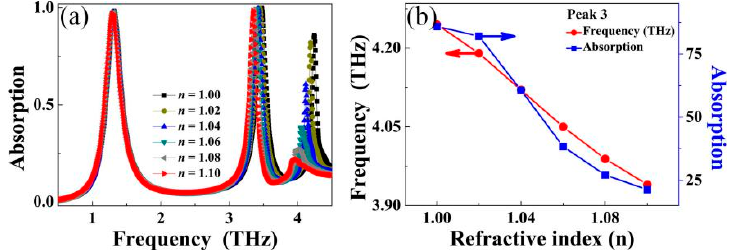
Figure 3. ( a ) Absorption spectra of refractive index change of surrounding; ( b ) frequency and absorbance of the third absorption peak as the function of the refractive index of the surrounding.